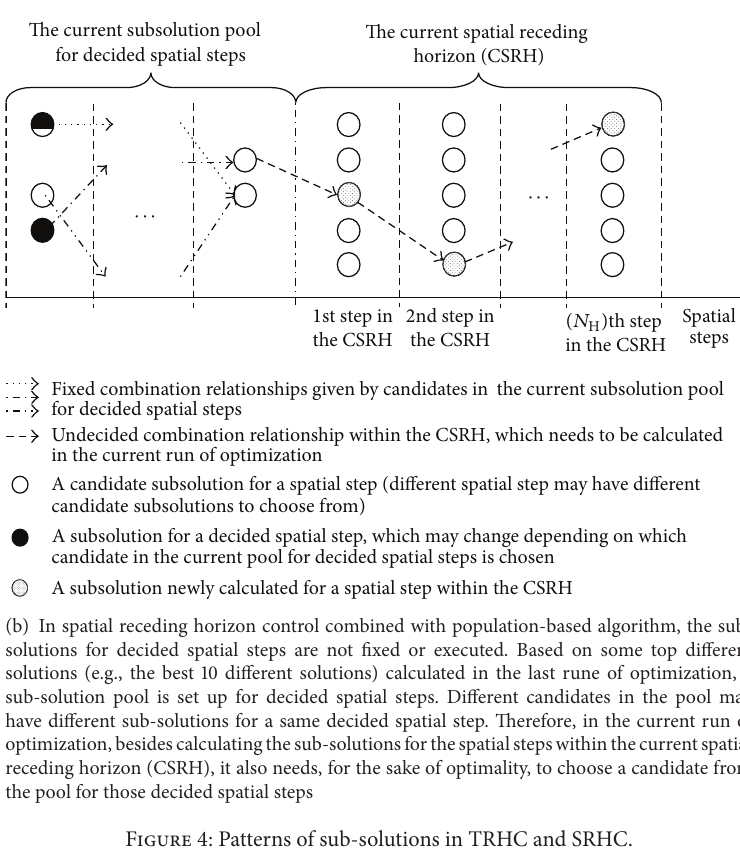
Figure 4: Patterns of sub-solutions in TRHC and